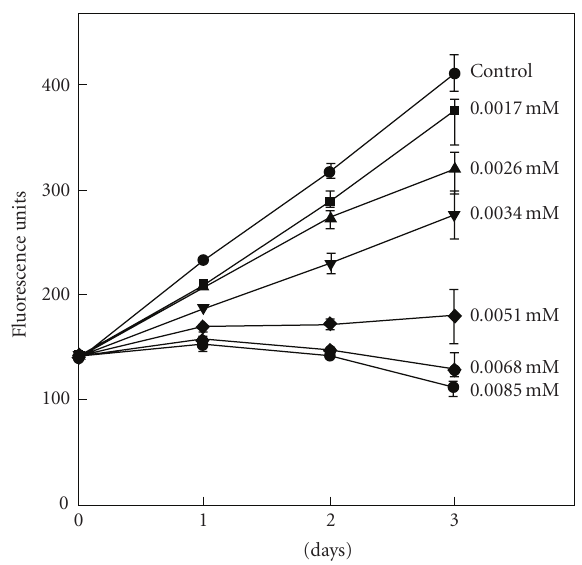
Figure 16: Time course of Smulow-Glickman (S-G) gingival cells growth to a continuous three-day exposure to sanguinarine. Cellular DNA was estimated with the fluorochrome, Hoechst 33258 using an excitation wavelength of 360 nm and emission wavelength of 460 nm. Reprinted from Babich et al. [137] with permission from John Wiley and Sons